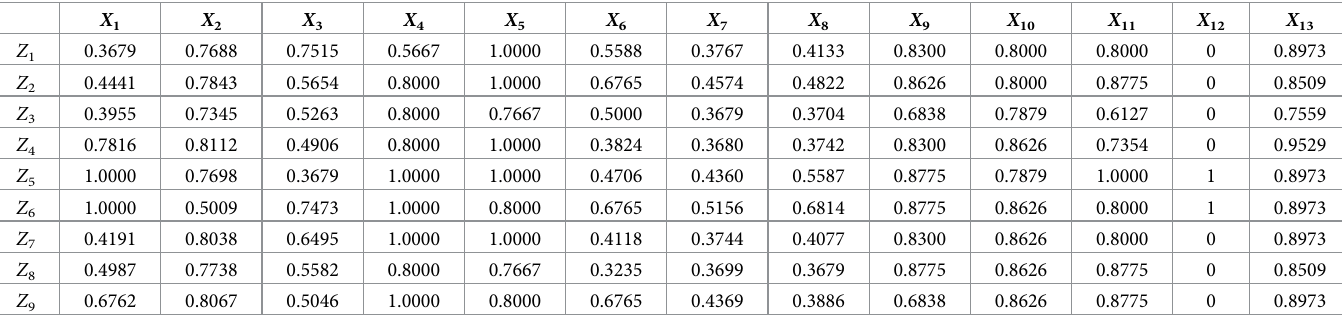
Table 5. Local similarities of heterogeneous